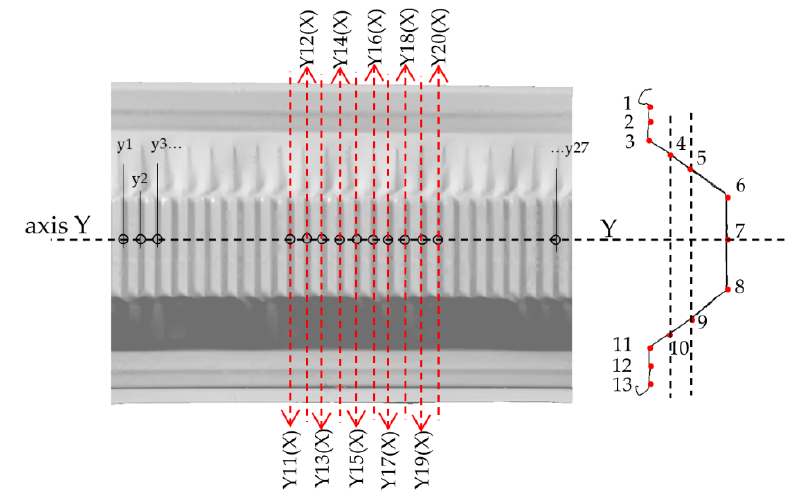
Figure 10. The reference points locations, Model 0 .